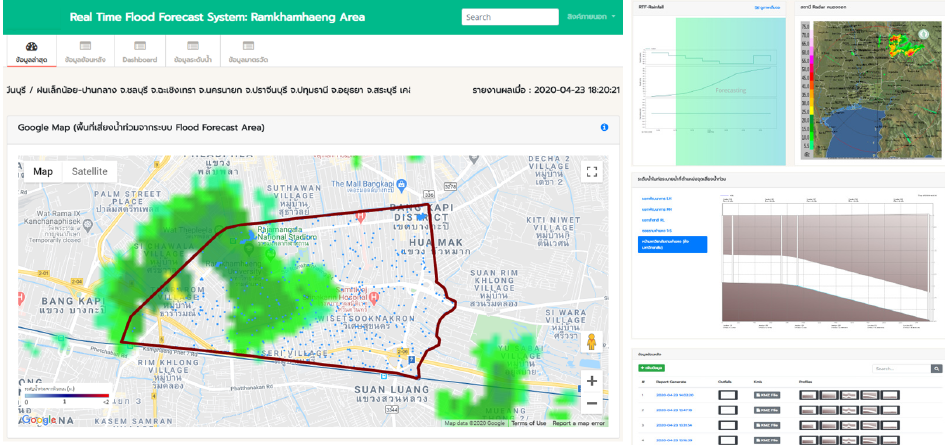
Figure 10. The result of the RTFlood system displayed on a